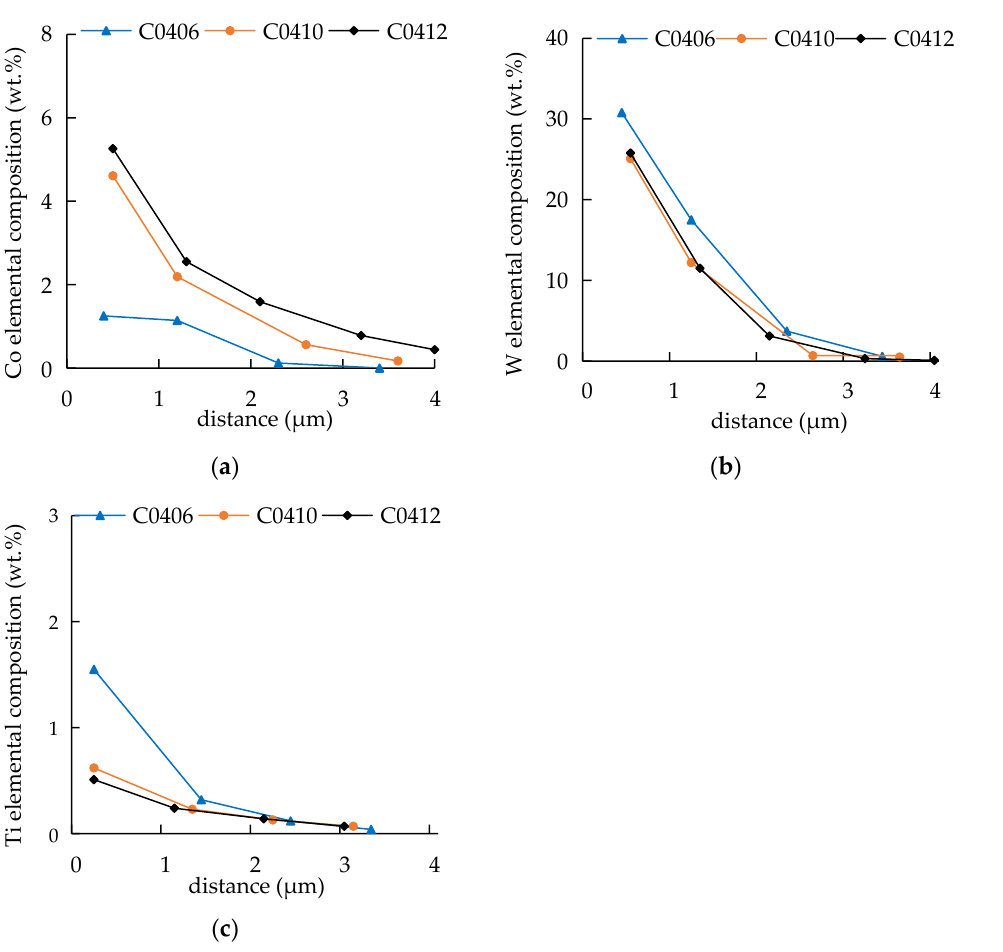
Figure 6. Diffusion between cemented carbide samples with different element contents and the Ti6Al4V. ( a ) Diffusion of the Co element; ( b ) Diffusion of the W element; ( c ) Diffusion of the Ti element.